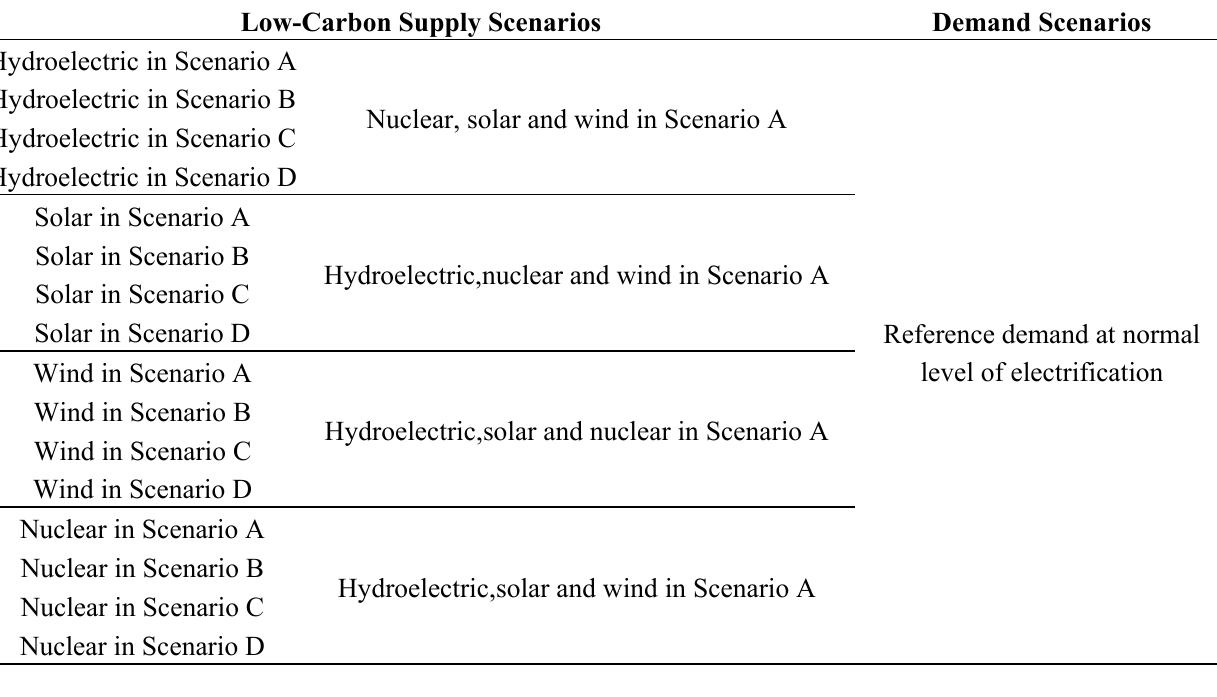
Table 13. Scenarios used for analyzing contributions of each low-carbon supply to carbon dioxide mitigation with the reference demand trend.